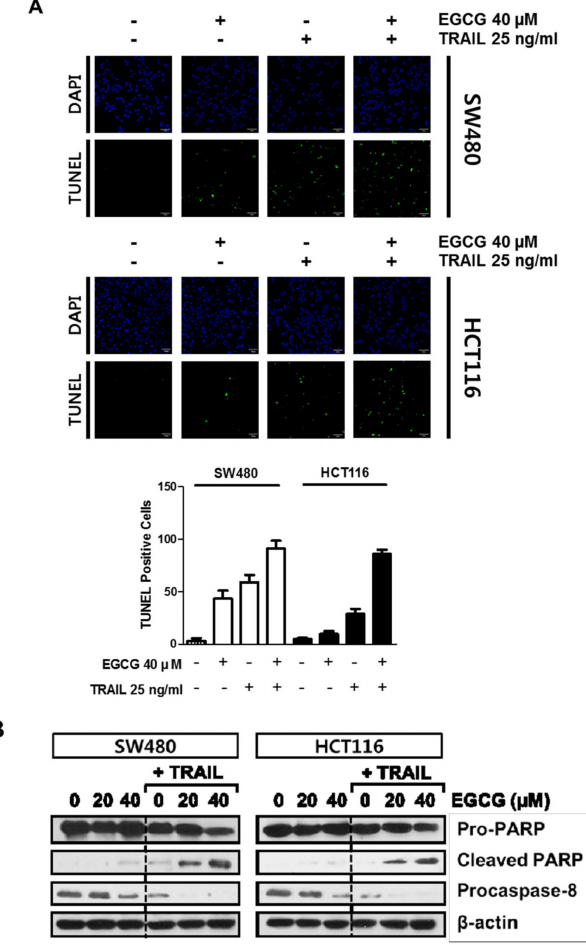
Figure 2. Cotreatment of EGCG and TRAIL increased the number of terminal deoxynucleotidyl transferase-dT-mediated dUTP nick end labelling (TUNEL)-positive cells and induced poly (adenosine diphosphate-ribose) polymerase (PARP) cleavage and caspase 8 activation in SW480 and HCT116 cells. ( A ) E ff ect of EGCG and TRAIL on the number of TUNEL-positive cells in SW480 and HCT116 cells. SW480 and HCT116 cells were treated with TRAIL 25 ng / mL and / or EGCG 40 µ M for TUNEL staining. The fluorescent signals from fragmented DNA (green), and DAPI (blue) were visualized and photographed by FLUOVIEW FV10i confocal microscopy. Magnification bar = 50 µ m. Bar graphs represent quantification of TUNEL-positive cells (%). ( B ) E ff ect of TRAIL and EGCG on PARP cleavage and caspase 8 in in SW480 and HCT116 cells. SW480 and HCT116 cells were treated with TRAIL (25 ng / mL) and / or EGCG (20, 40 µ M) for 24 h. Cell lysates were prepared and subjected to Western blotting with the indicated antibodies. β -actin was used as an internal